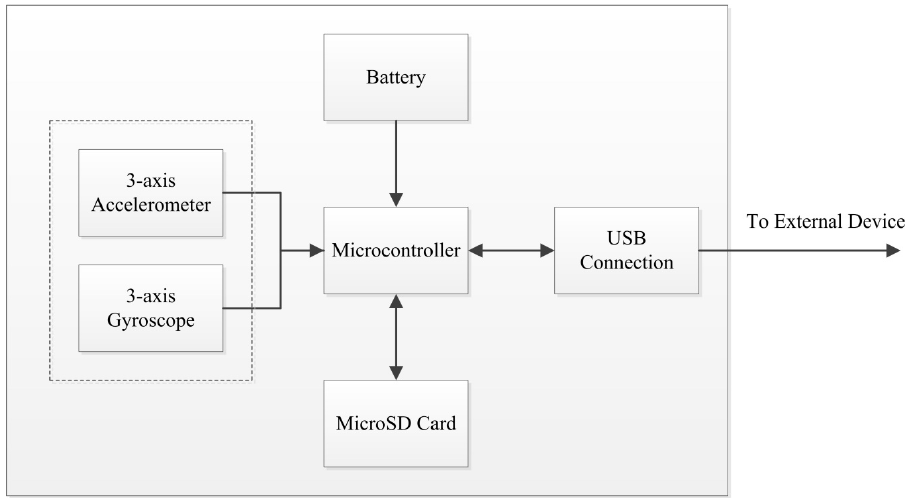
Figure 30. Example of typical system architecture found in inertial-sensor based devices used for the analysis of